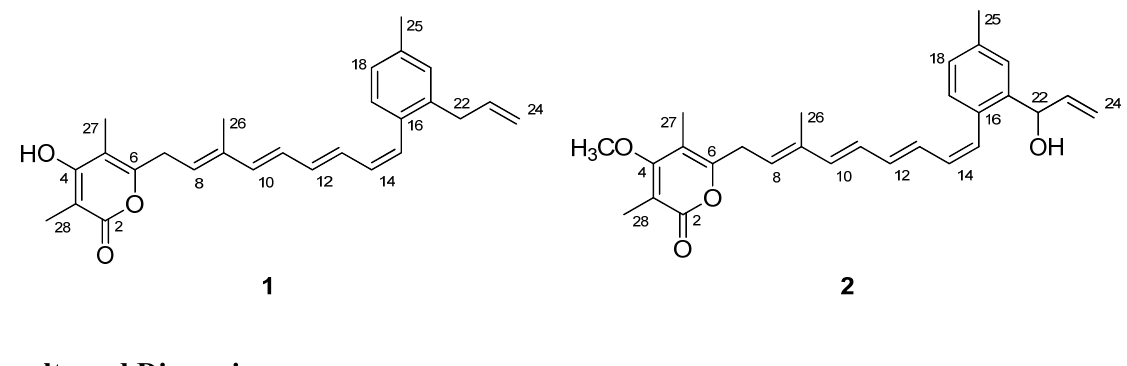
Figure 1. Structures of gombapyrone E ( 1 ) and F ( 2